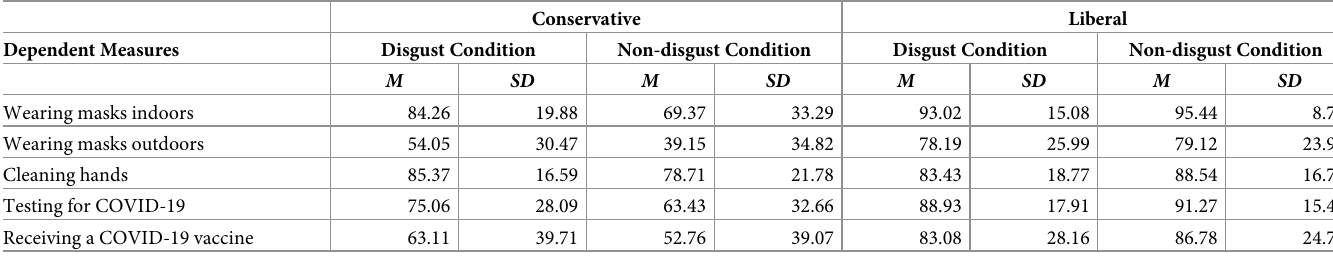
Table 1. Descriptive statistics for the five sets of dependent measures for conservative and liberal participants in each condition.